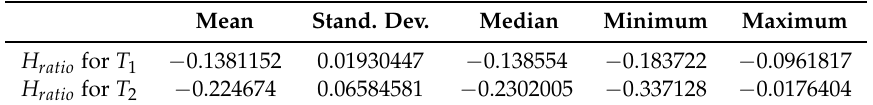
Table 5. Statistics of H ratio exp for the T 1 w and the T 2 w images for the 60 Parkinson’s disease patients. The H ratio exp are significantly negative for all images and hence all the restorations are successful. Mean Stand. Dev. Median Minimum Maximum H ratio for T 1 − 0.1381152 0.01930447 − 0.138554 − 0.183722 − 0.0961817 H ratio for T 2 − 0.224674 0.06584581 − 0.2302005 − 0.337128 −